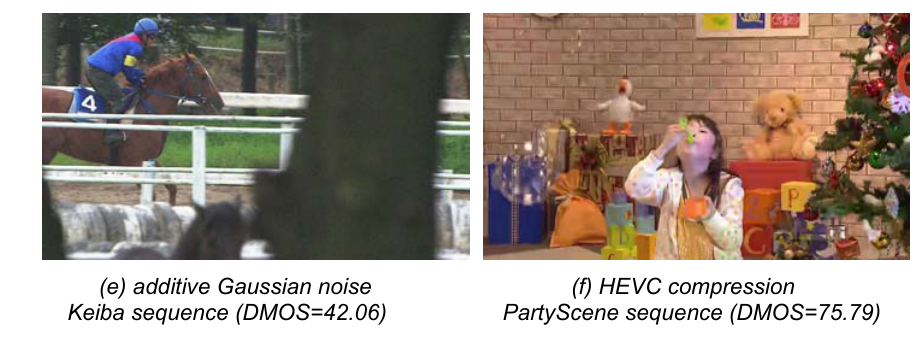
Figure 8 – Example frames of the test sequences used in the CSIQ Video Dataset Рис . 8 – Примеры кадров тестовых последовательностей на основании